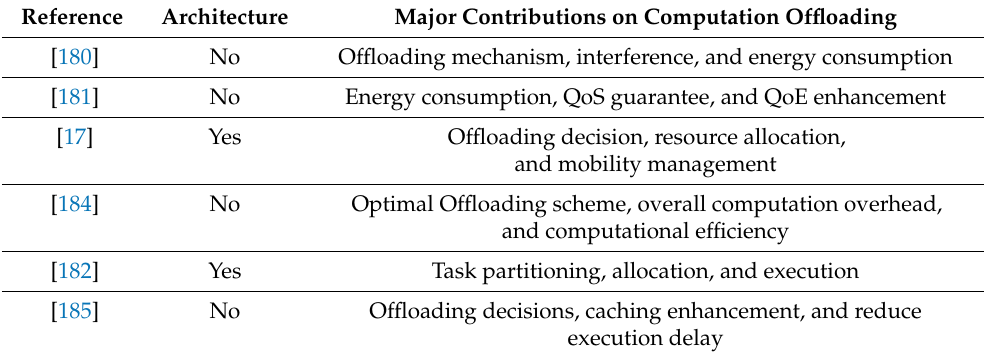
Table 5. Summary of key articles on computation